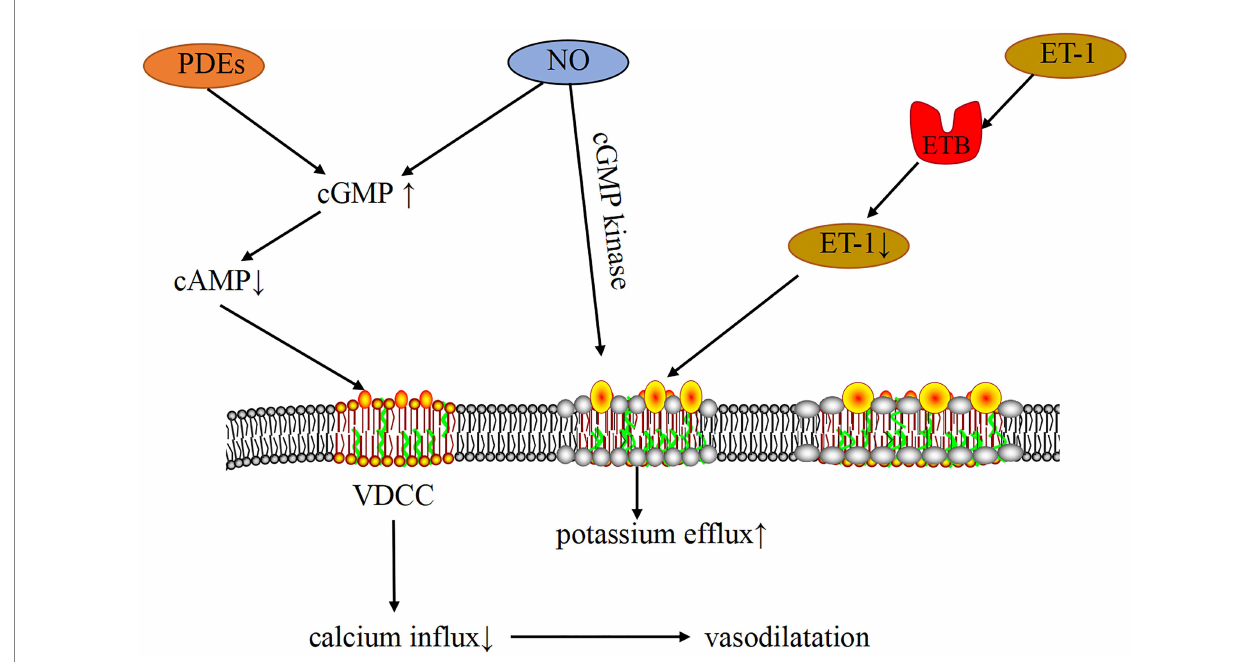
FIGURE 5 Mechanism of PH-LHD-related vasoconstriction induced by the ion channel. PDEs and NO can increase cGMP, decrease cAMP, inhibit the activity of VDCC, reduce Ca 2+ influx, and cause vasodilation. In addition, cGMP can activate KV through cGMP kinase, thereby inhibiting the activity of VDCC and causing vasodilation. ET-1 binds to ET-1B receptor, which can clear ET-1, decrease ET-1 concentration, activate KV, inhibit VDCC activity, increase Ca 2+ influx, and cause